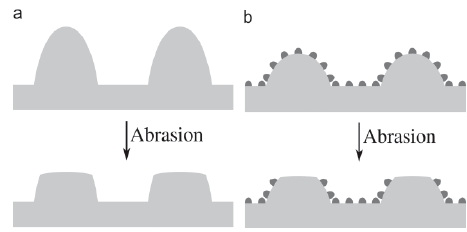
Figure 3. The effect of abrasion on surfaces with ( a ) micro roughness alone and ( b ) surface patterned with mechanically stable micro bumps with nano roughness [61].